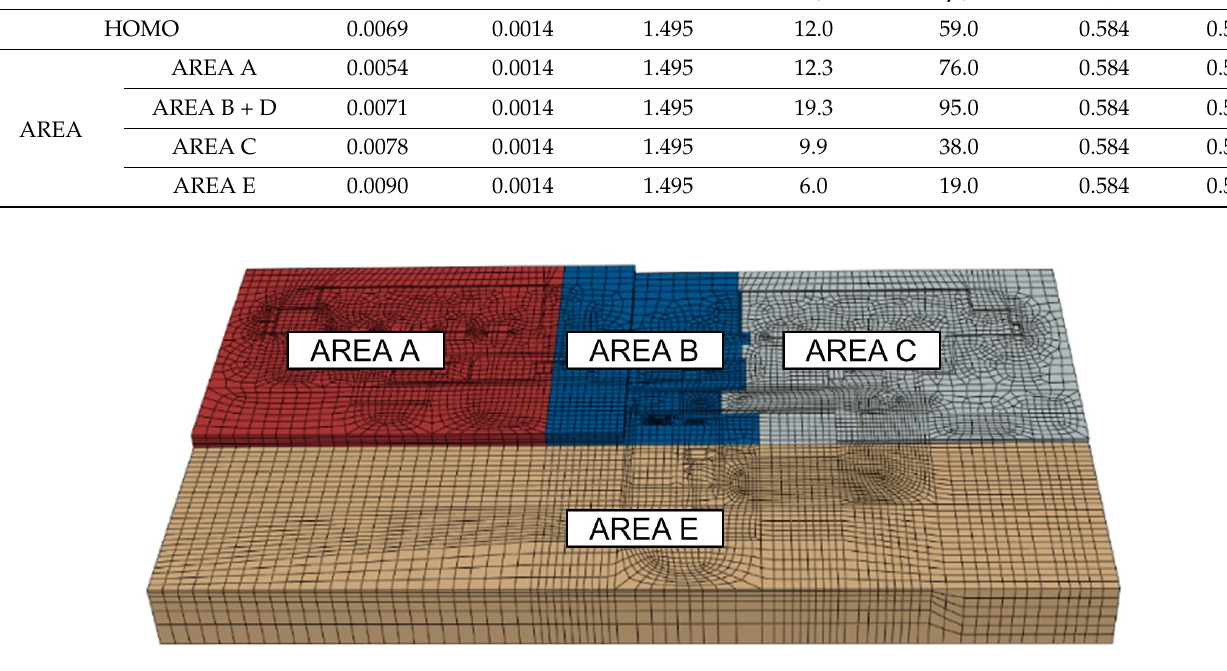
Figure 15. Vertical displacements in selected subsequent calculation steps [m]: ( a ) construction of the underground floor, ( b ) stage of construction at measurement 1, ( c ) stage after finishing the con- struction.